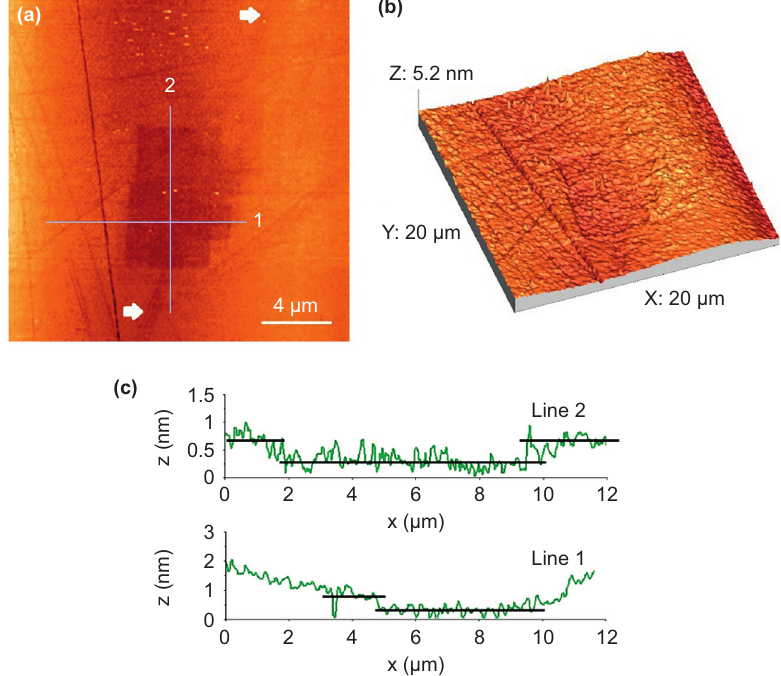
Figure 2. AFM topographical characterization of SiC substrates after scratched with the artemisinin crystal-modi fi ed probe shown above for 60 min in DI water. (a) The two-dimensional topographical image. The image was only fi rst-order fl attened without other fi ltering treatments. The scratching area was 5 μ m × 5 μ m for this case. Apparent multiple squares (four of them) were visible. Numbers 1 and 2 indicate two lines for line pro fi le analyses shown in (c). Two arrows in the image draw the attention to a straight scratch line that disappeared within the scratched area. (b) Three-dimensional rendering of the topographical image, the scratched areas were clearly visible. (c) Line pro fi les along two lines 1 and 2 marked in (a), indicating a maximum depth of 0.5 nm of the scratched area. Note the bow of the image appeared in (b) and line pro fi le for line 1 was an artifact caused by image- fl attening operation with the